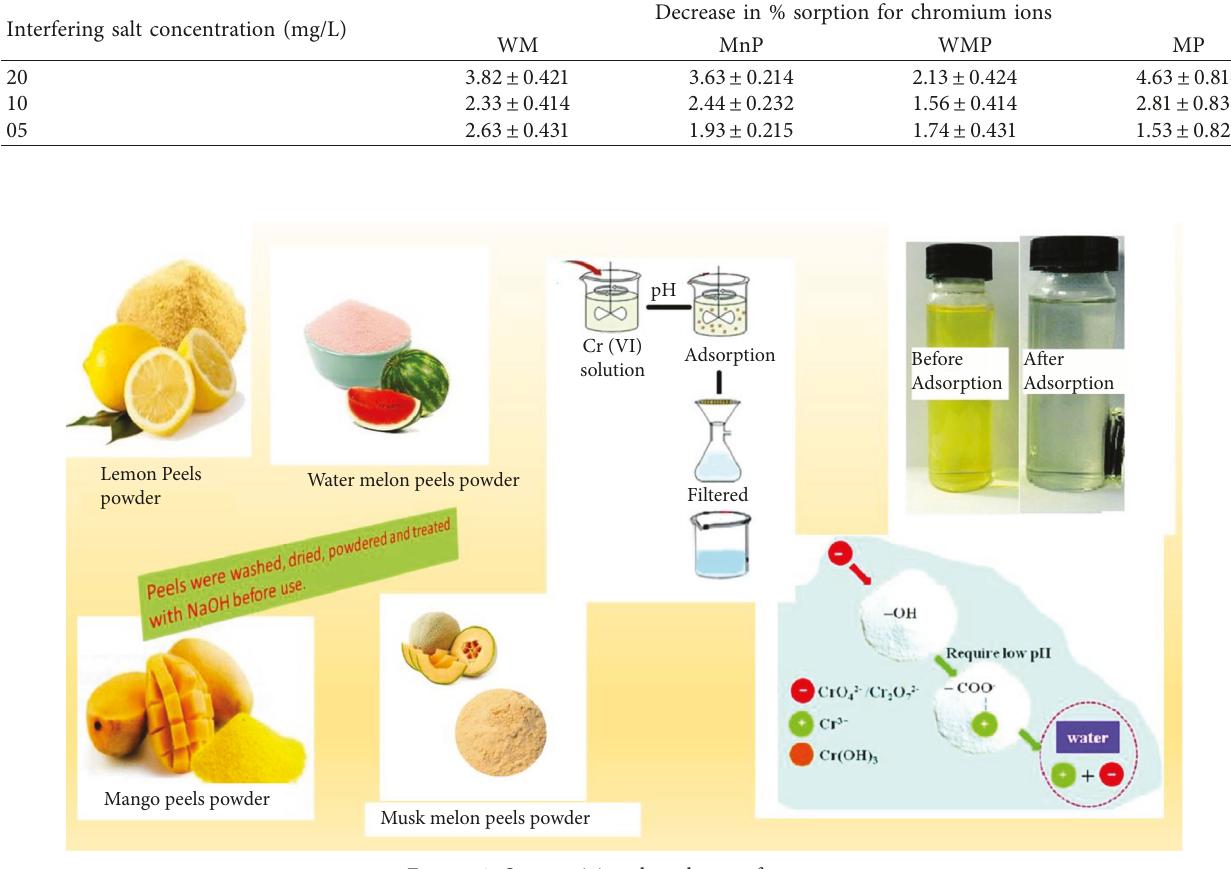
Figure 9: Summarizing the scheme of process. Table 8: Percent sorption and percent recoveries of Cr